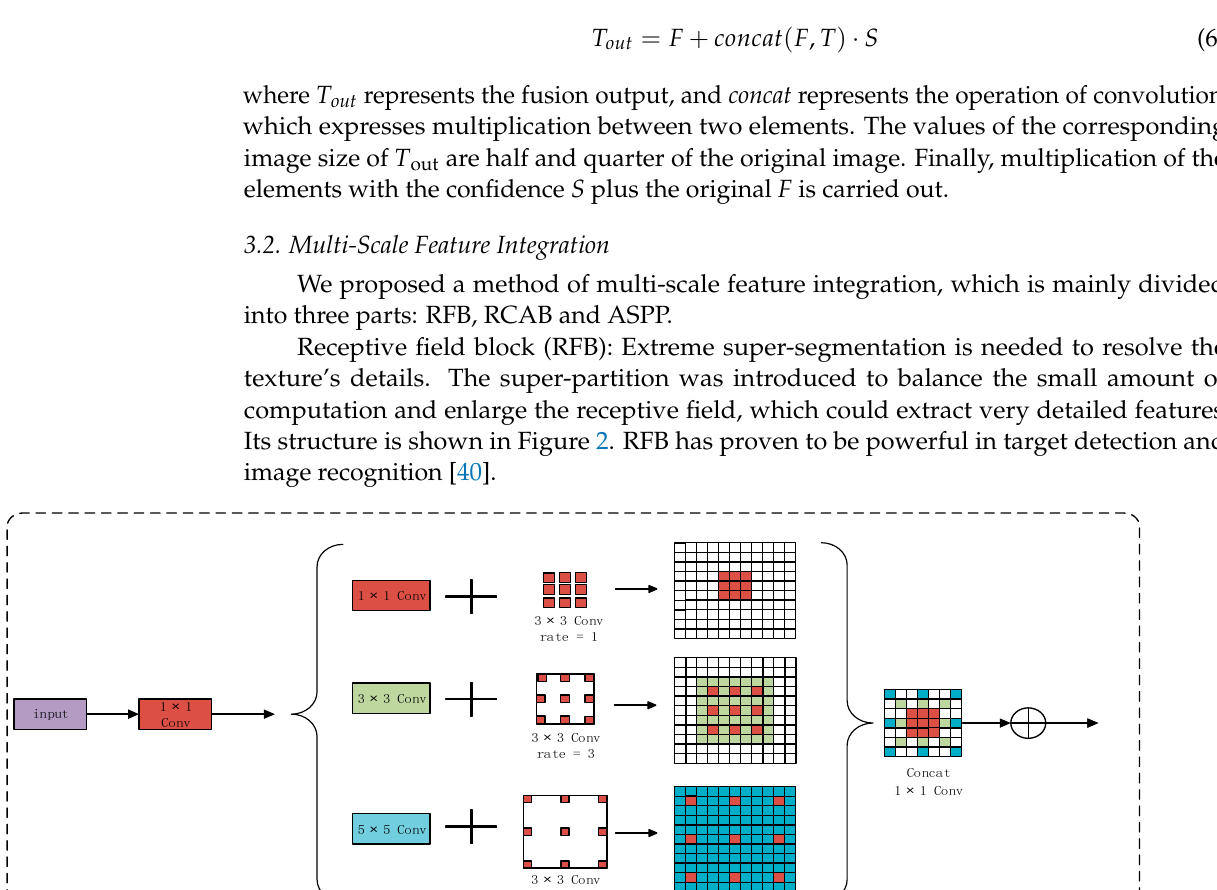
Figure 3. Atrous spatial pyramid pool. Figure 4. Multi-residual channel attention block.